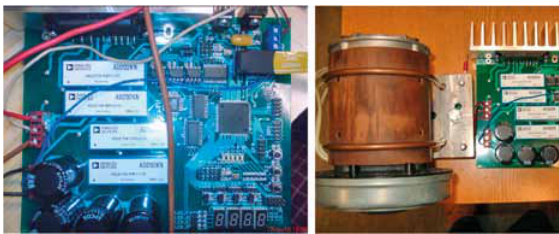
Fig. 3. Photo of the converter and the BLDC motor